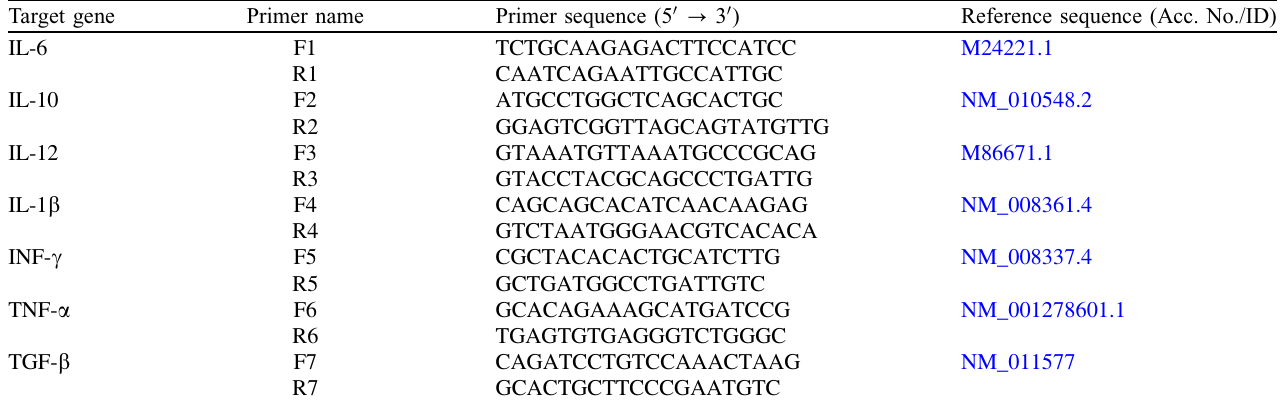
Table 1. Primers used in real-time quantitative PCR. Target